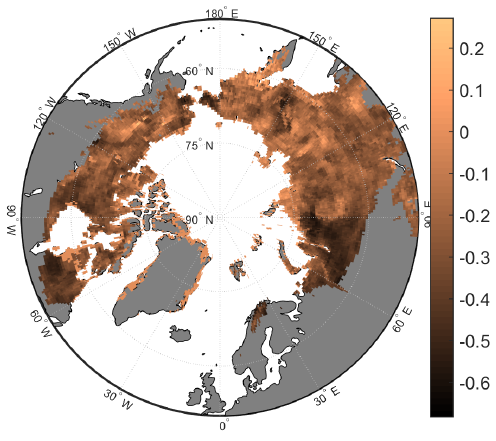
Figure 7. Autumn (SON) 1980–2009 average snowmelt relative dif- ference. Relative difference (REDVAR − CNTL)/CNTL expressed as a fraction